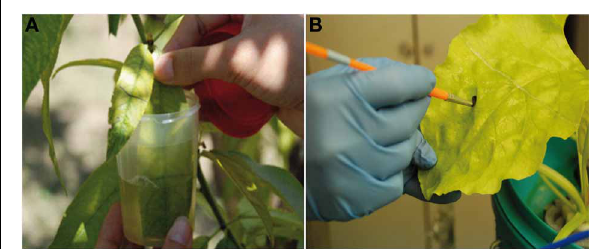
FIGURE 2 | Treatment of the distal half part of (A) peach tree leaves grown in the field by dipping into the Fe formulation and (B) sugar beet leaves grown in hydroponics using a paintbrush to apply the Fe formulation. In both cases, a solution containing 2mM FeSO 4 and 0.1% surfactant was